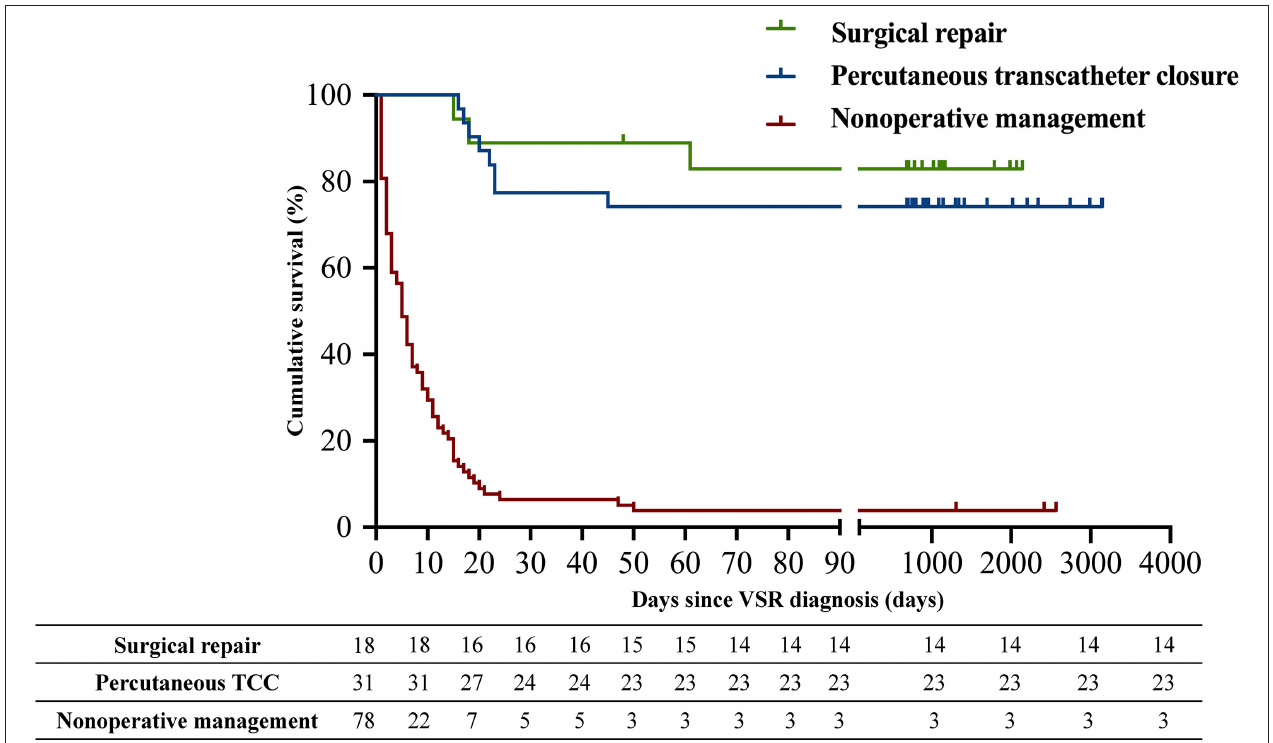
FIGURE 1 | Kaplan-Meier estimates of cumulative event-free survival for long-term mortality.